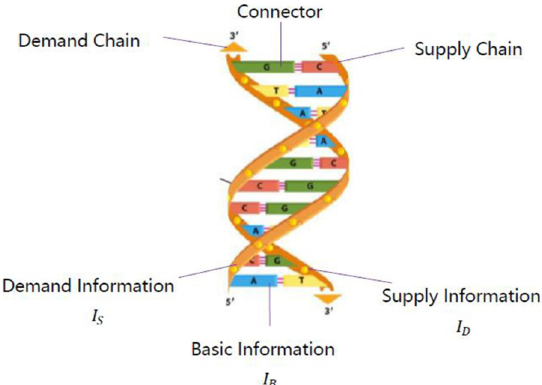
Figure 1. DNA-styled double- chain structure of the MCIN